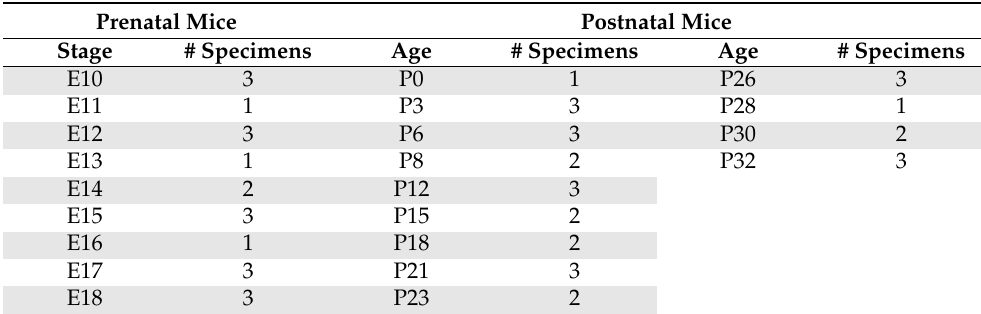
Table 1. Sample sizes of the embryonic (E) and postnatal (P) mouse specimens studied here, where the number (e.g., 10) is either the day post-conception (E) or post-birth (P). Prenatal Mice Postnatal Mice Stage # Specimens Age #